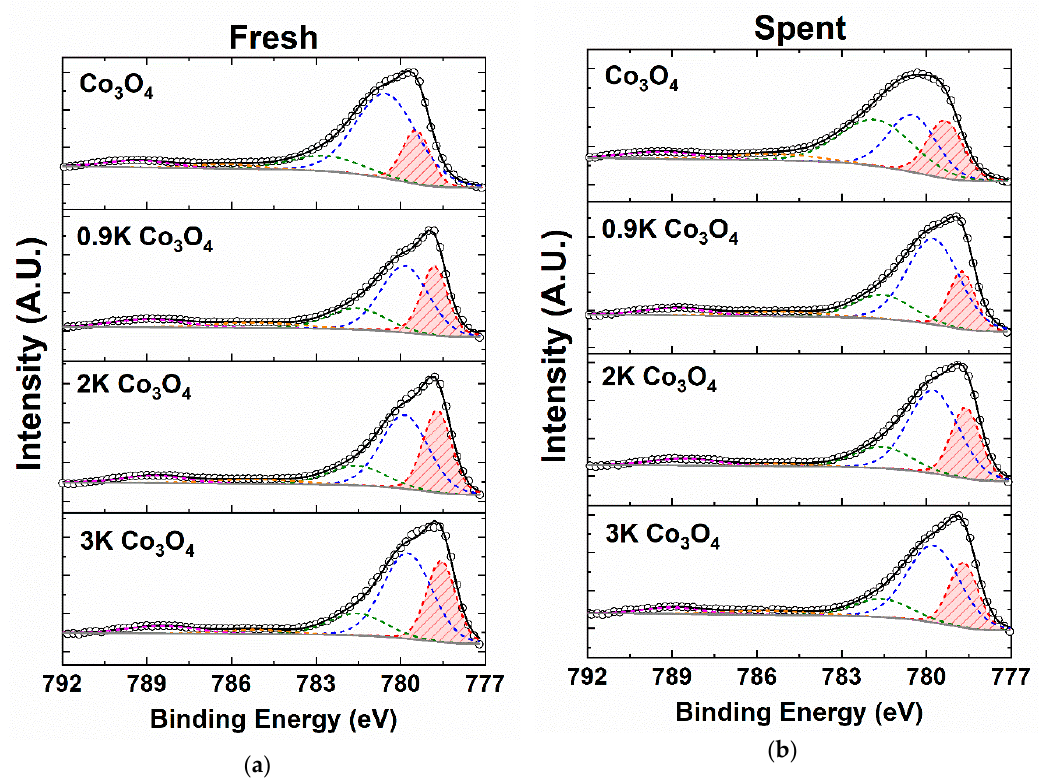
Figure 12. Co 2p 3/2 X-ray photoelectron spectroscopy (XPS) spectra of: ( a ) fresh and ( b ) spent Co 3 O 4 catalysts with varying K loadings. Colored dashed lines are the peaks utilized identified during fitting, the solid gray line is the background, and the solid black line is the fit. The low binding energy peak is shaded red to emphasize changes with K loading and the effect of reaction environment.